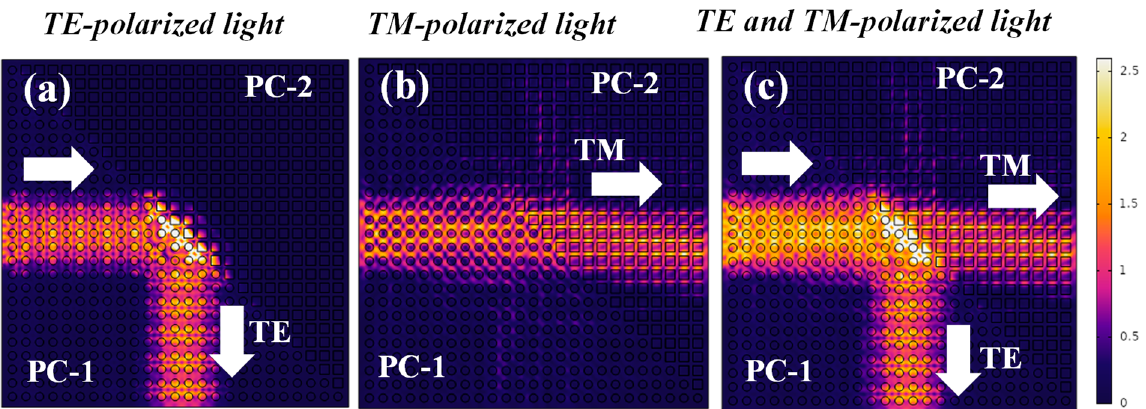
Figure 6. Norm. electric field mapping at λ = 1550 nm for ( a ) light with TE-polarization, ( b ) light with TM-polarization, ( c ) TE + TM-polarization of light.